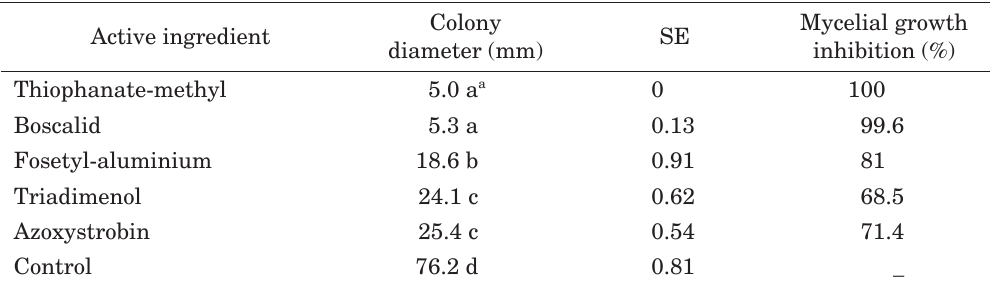
Table 2. Diameters of Seiridium cardinale colonies on 2% MEA amended with fungicides after 3 weeks at 25°C. The control was non-amended 2% MEA. Percentage growth inhibition was determined for each fungicide with reference to growth on non-amended MEA (subtracting the diameter of the mycelium plugs). The mycelium plugs used to initiate colonies were 5 mm in